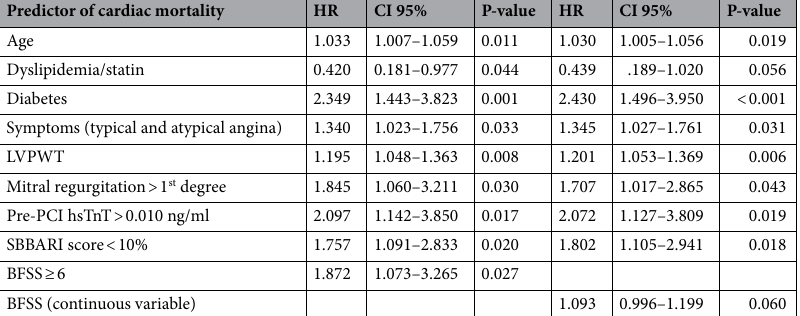
Table 6. Independent predictors of cardiac mortality on multivariate analysis. LVPWT left ventricular posterior wall thickness, PCI percutaneous coronary intervention, hsTNT high sensitive troponin T, BFSS bifurcation functional significance